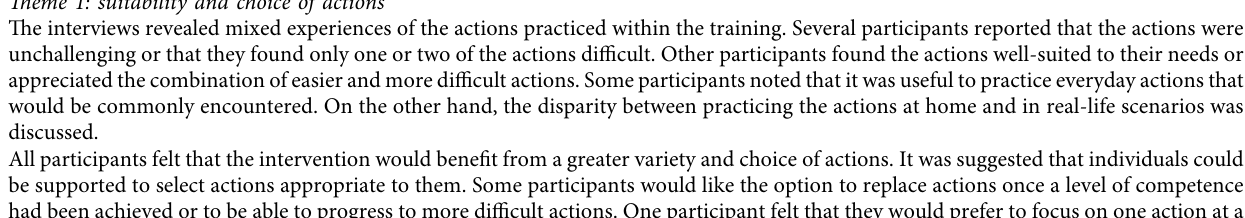
Table 2: Themes generated from semistructured posttraining